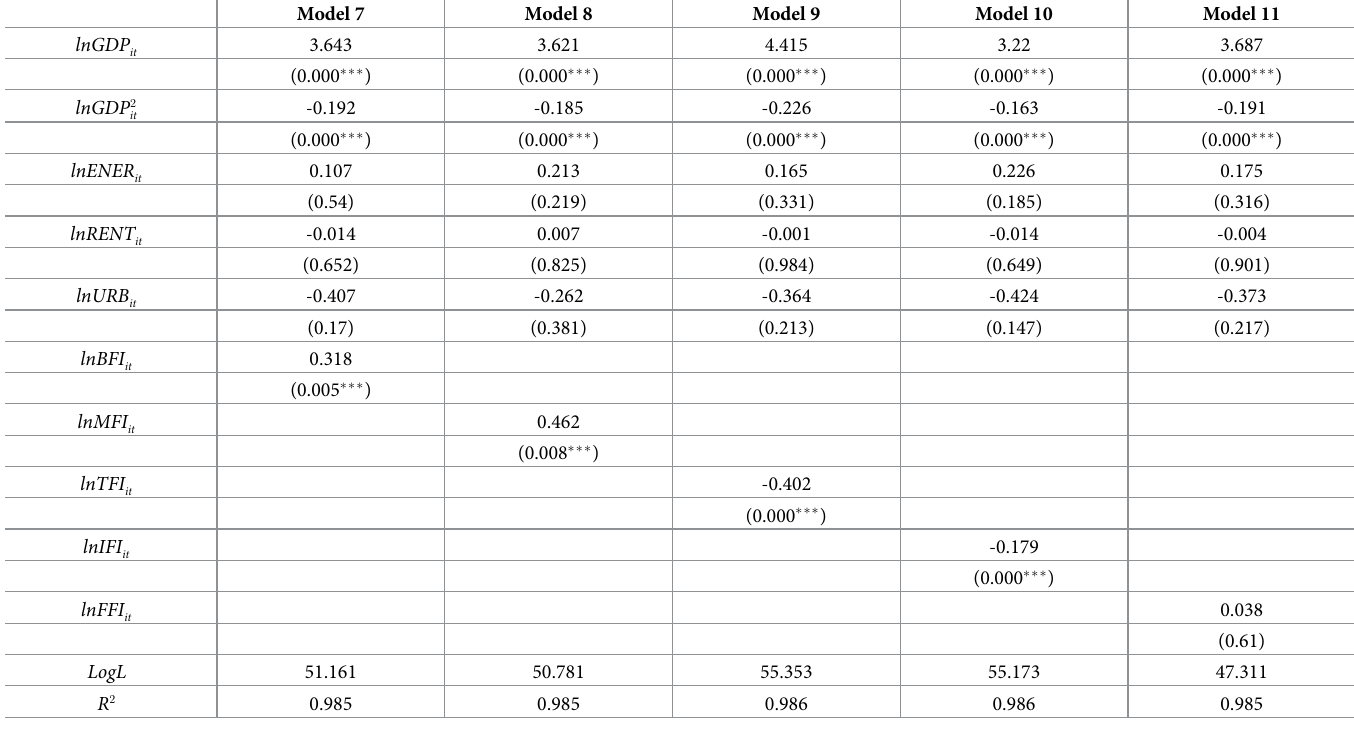
Table 6. Estimation results of PFMOLS Model 7–11 (when the variable included are